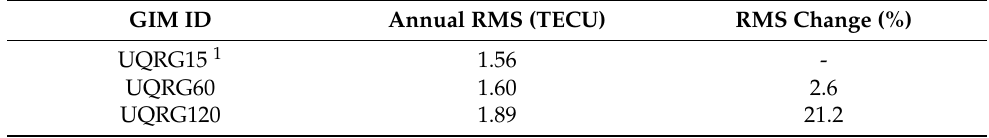
Table 4. Annual RMS from GNSS-STEC comparisons for all analyzed GIMs in